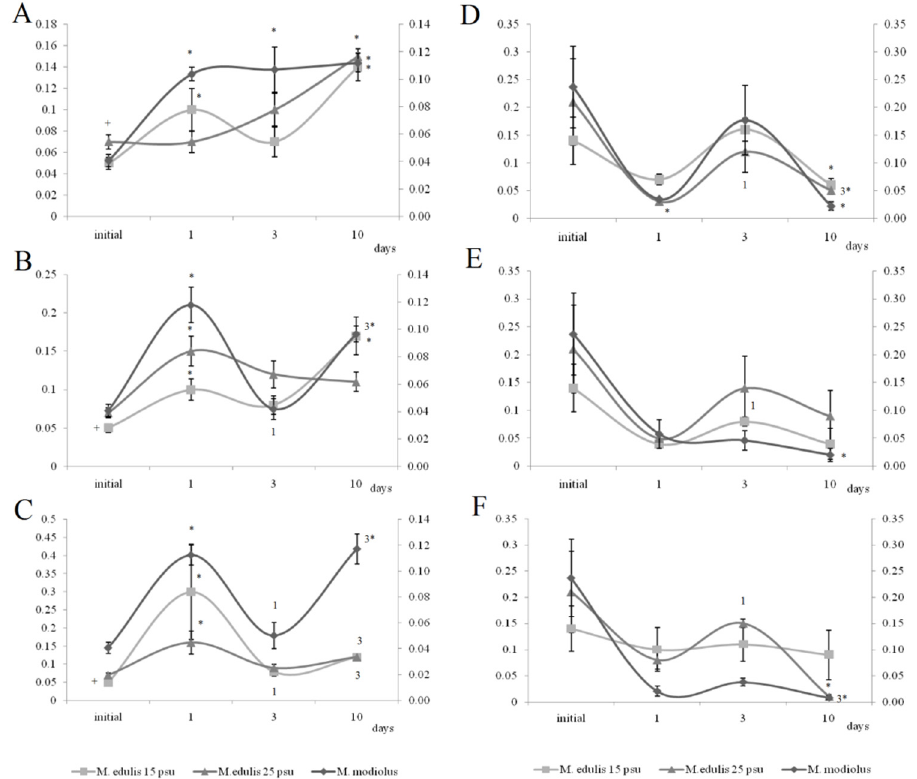
Figure 5. PEA/PC ratio in gills ( A – C ) and digestive glands ( D – F ) of horse mussels and blue mussels under low (L), medium (M), and high (H) crude oil concentrations. Values are means ± standard error ( n = 5). * significant results in comparison with initial level; 1, 3—significant results in comparison with first and third days of exposure. Differences were estimated by the nonparametric Kruskal–Wallis test, p < 0.05 + significant differences between mussels acclimated to 15 and 25 psu were estimated by the nonparametric Mann–Whitney U test, p < 0.05.